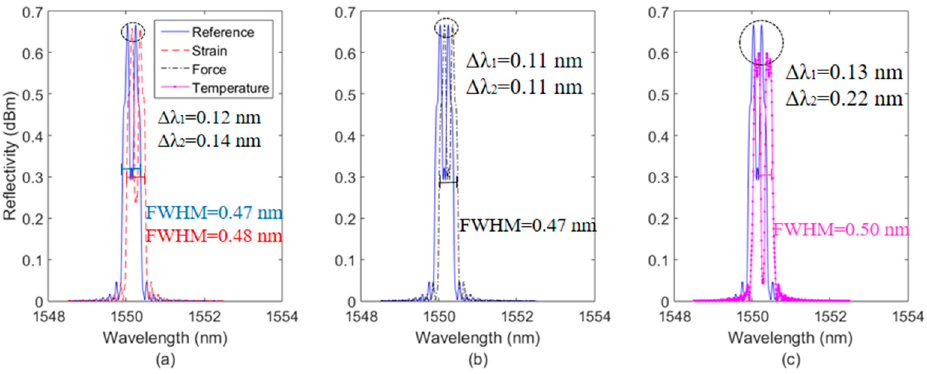
Figure 2. Simulated spectra of half-embedded FBGs for ( a ) strain variation of 100 µε , ( b ) force variation of N and ( c ) temperature variation of 15 °C.